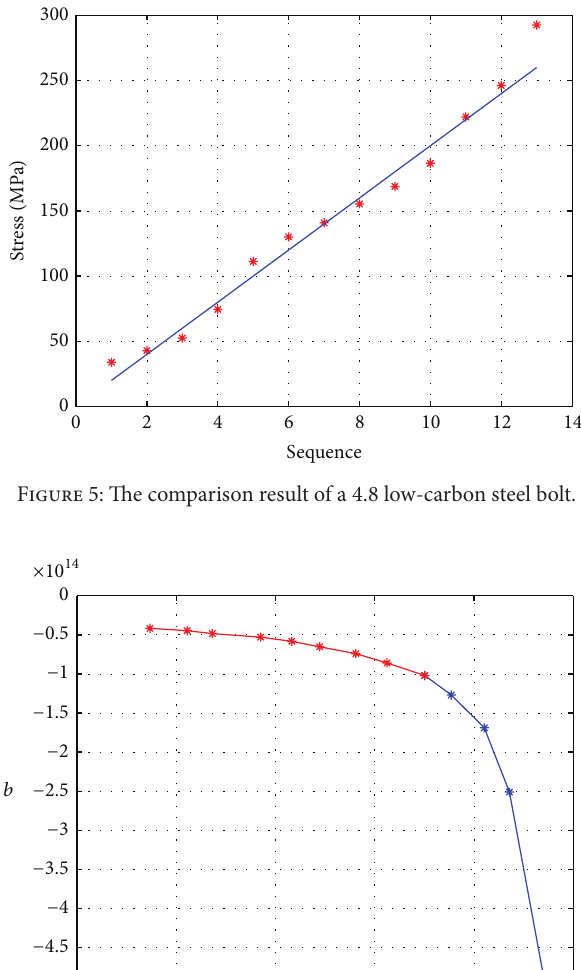
three stress measurement regions. The average error of this new method is less than 20 MPa from Figures 3, 5, and